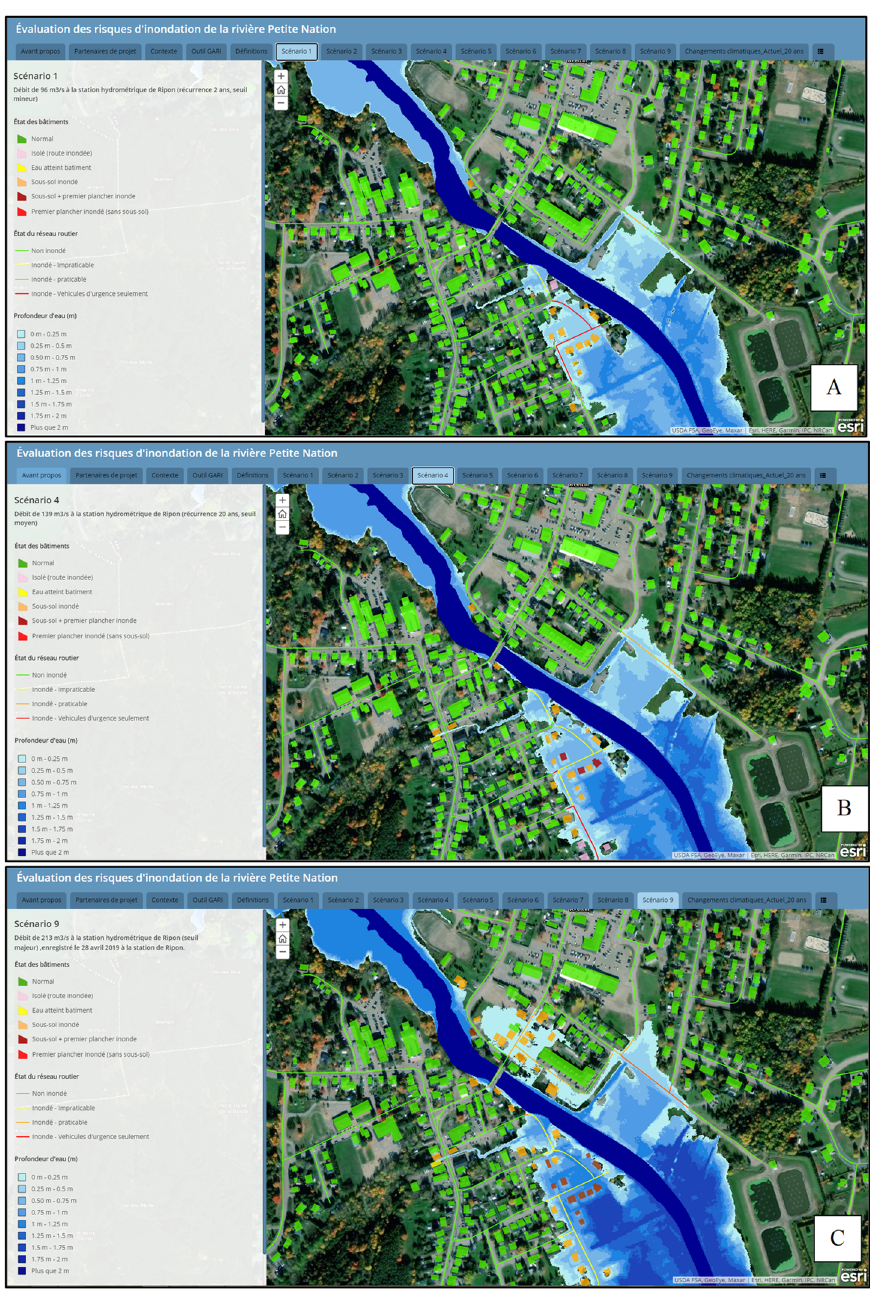
Figure 5. Screenshot of slides 6 (A: Scenario 1), 9 (B: Scenario 4) and 14 (C: Scenario 9).